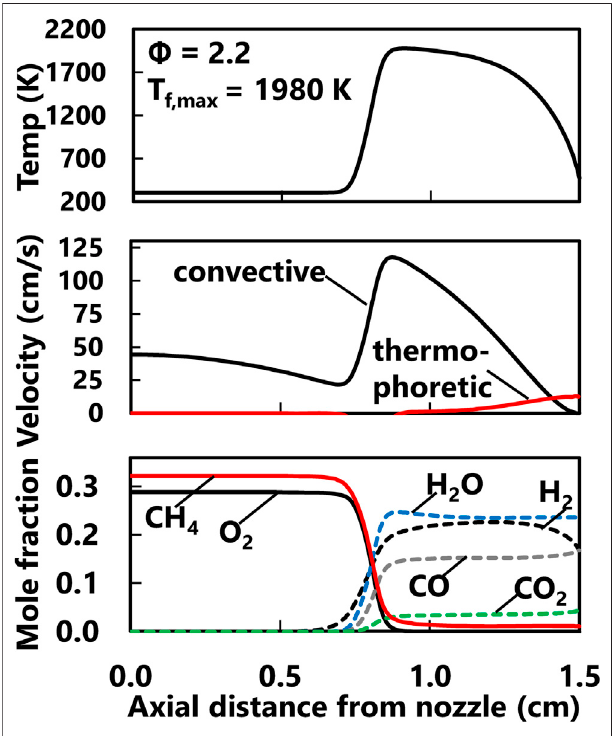
FIGURE 6 | Computed axial temperature pro fi le (top) , axial velocity pro fi les (middle) and major products (bottom) at the centerline for the Φ (cid:1) 2.2, T f,max (cid:1) 1,980 K fl